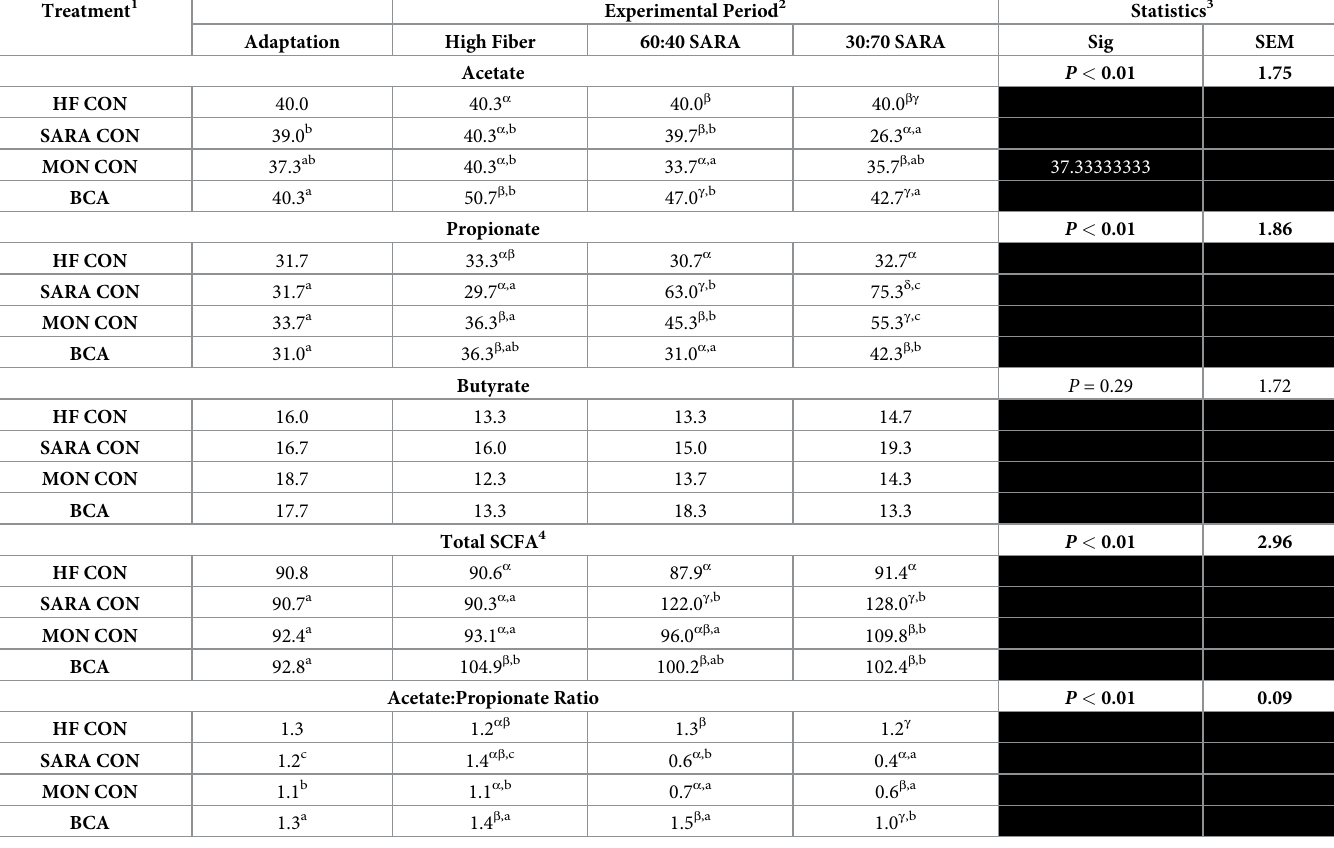
Table 4. Effect of biochanin A on rumen fluid short chain fatty acid (SCFA) concentrations at 4 h post-feeding (mmol L -1 ; true means; n = 3). Treatment 1 Experimental Period 2 Statistics 3 Adaptation High Fiber 60:40 SARA 30:70